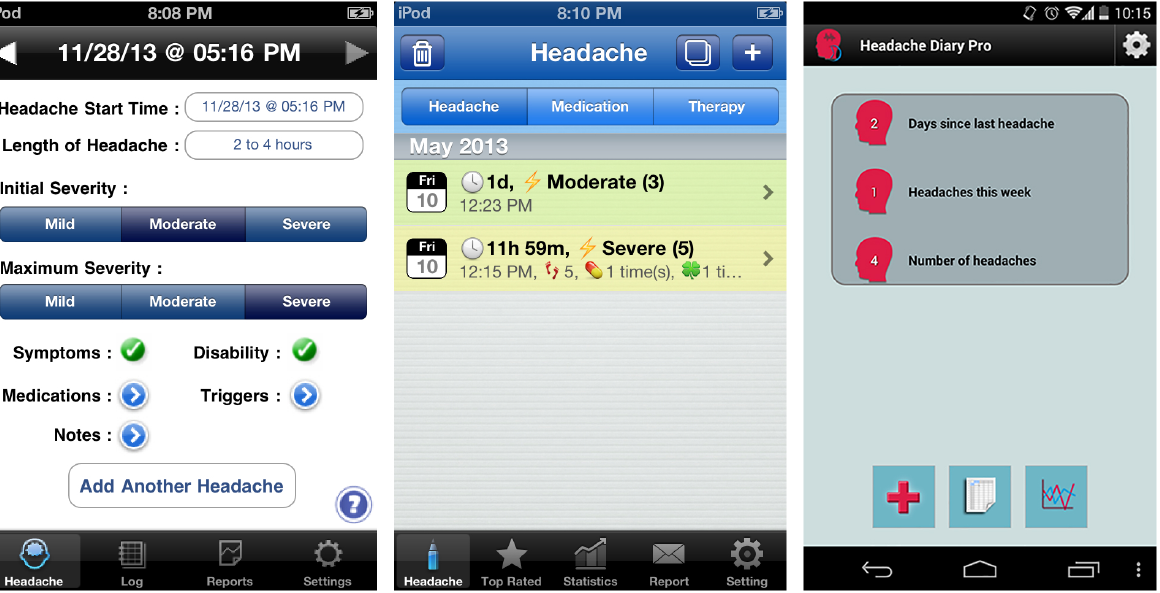
Figure 1. The home screen of iHeadache (left), ecoHeadache (middle), and Headache Diary Pro